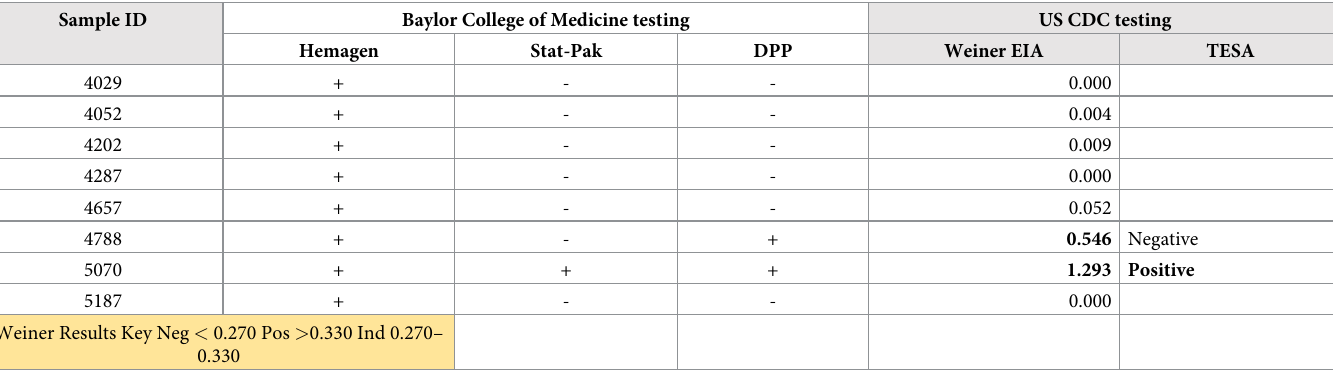
Table 1. Discordant testing results among Chagas disease diagnostics. Sample